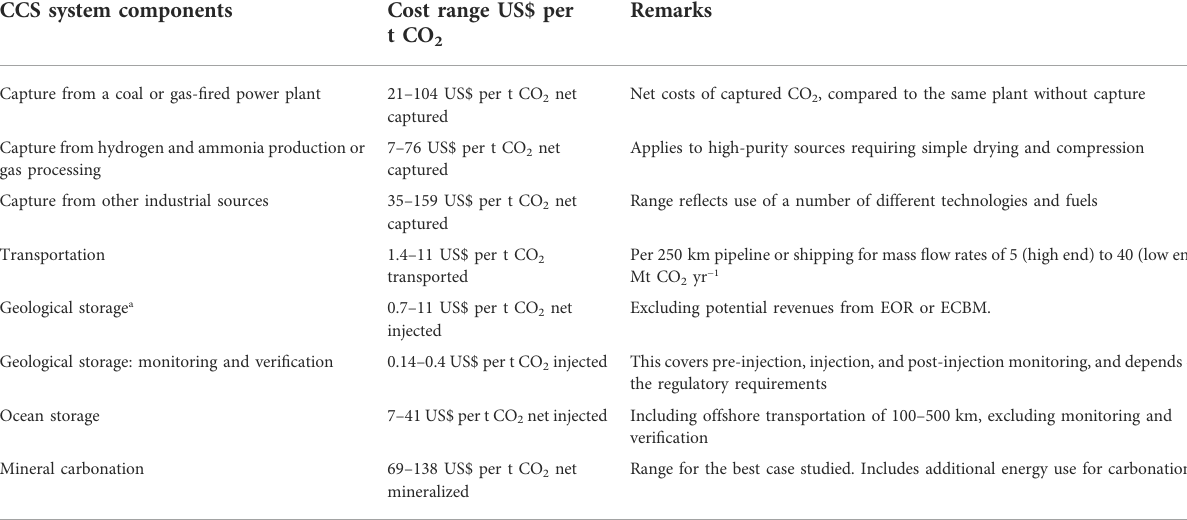
TABLE 1 Cost ranges for the components of a CCS system as applied to a given type of power plant or industrial